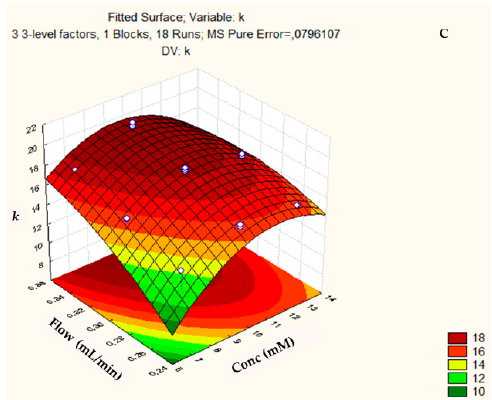
Figure 2. Three-dimensional response surface plot showing the effects of the mutual interactions between two independent variables ( a ) Flow and Temperature; ( b ) Concentration and Temperature and ( c ) Flow and Concentration on retention factor ( k ) of the chromatographic analysis on the ZIC-p-HILIC column. The response surface of the resolution (R) (Figure 3) achieved higher values when the temperature